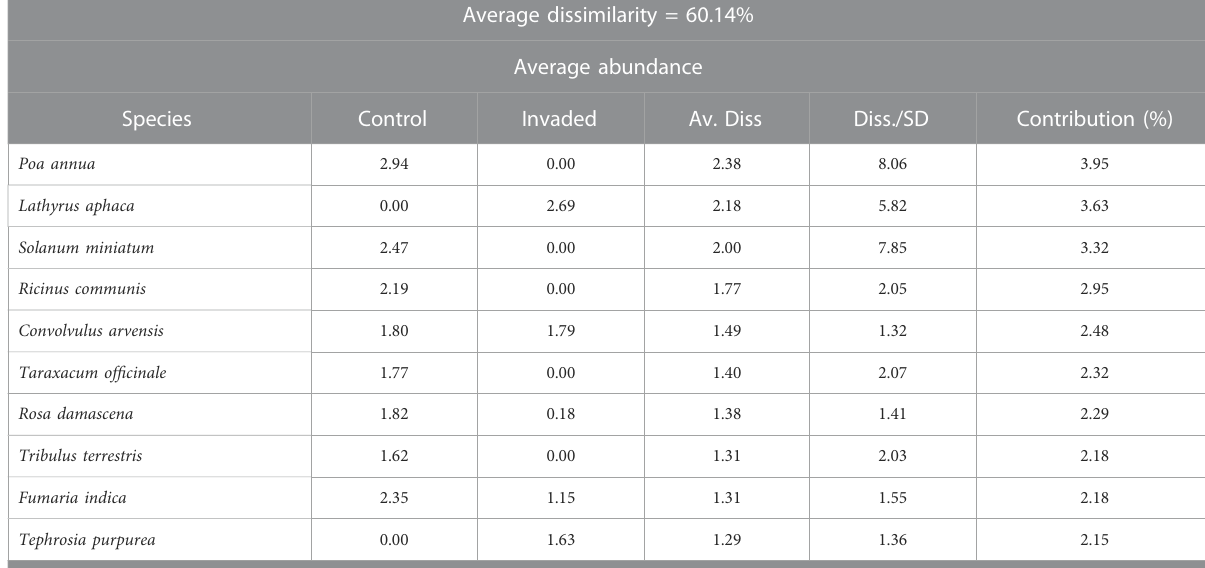
TABLE 1 SIMPER analysis of district-level data for P. hysterophorus invaded and control